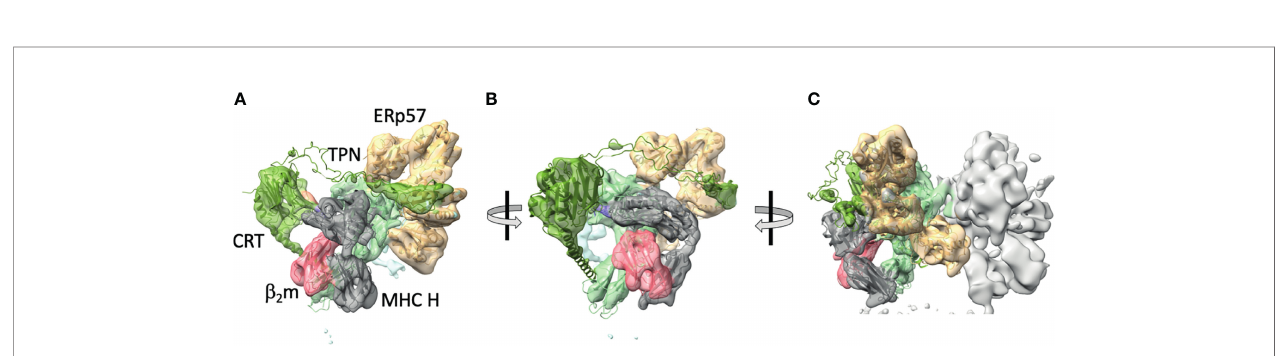
FIGURE 2 | Cryo-EM maps of the complete protein loading complex reveal spatial organization of its components. (A) 5.8 Å cryo-EM map of the PLC editing module (EMD-3906) with superposed X-ray -derived models (PDB-6ENY) as described by (23). (B) PLC rotated approximately 30° to center the b 2 m/MHC H chain module. (C) 7.2 Å cryo-EM map of the pseudosymmetrical PLC module, with the left side editing module colored and the right side one illustrating by map surface alone. Map and models with generated with ChimeraX. MHC H chain is grey, b 2 m is pink, calreticulin is green, tapasin is pale blue, and ERp57 is tan.